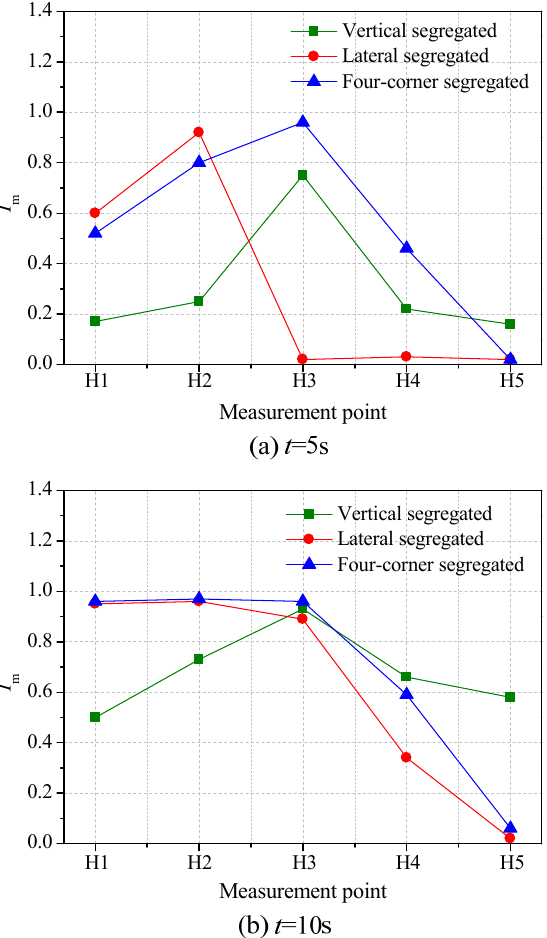
Figure 13. Lateral distributions of mixing index when three static beds are used after different time. ( a ) t = 5 s. ( b ) t = 10